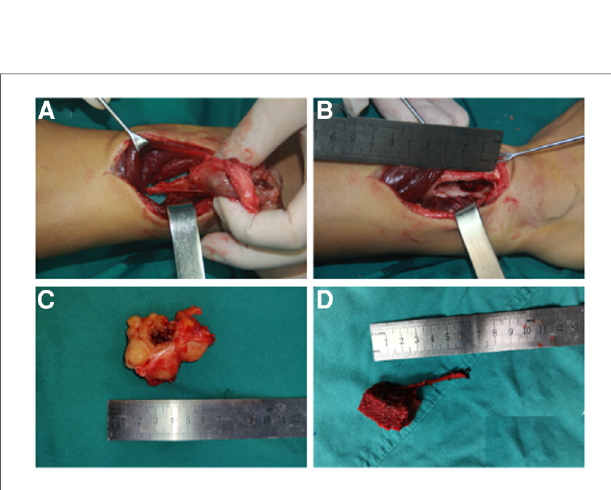
FIGURE 2 Intraoperative records of the lesion in the right forearm and free iliac bone fl ap. ( A ) Soft tissue mass originating from the dorsal interosseous nerve through the volar aspect of the distal radius. ( B ) A 3.5-cm-long radial bone defect through the dorsal aspect. ( C ) Macroscopic appearance of the excised lesion. ( D ) Macroscopic appearance of the vascularized free iliac bone fl ap for repairing the radial bone defect.